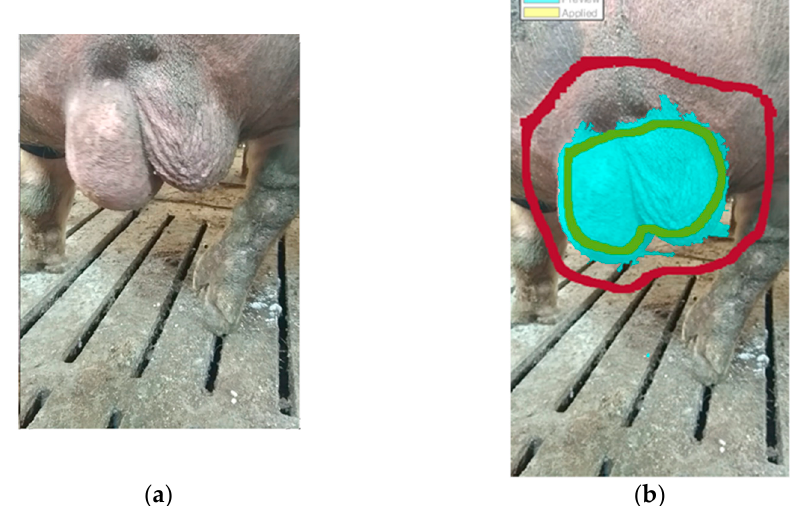
Figure 2. Segmentation of the scrotum area in a tagged video frame. ( a ) Unprocessed video frame imported in the Image Segmenter. ( b ) Video frame segmented with the Graph Cut algorithm, showing the foreground scribble (green color), the background scribble (dark red color) and the segmented area (cyan).